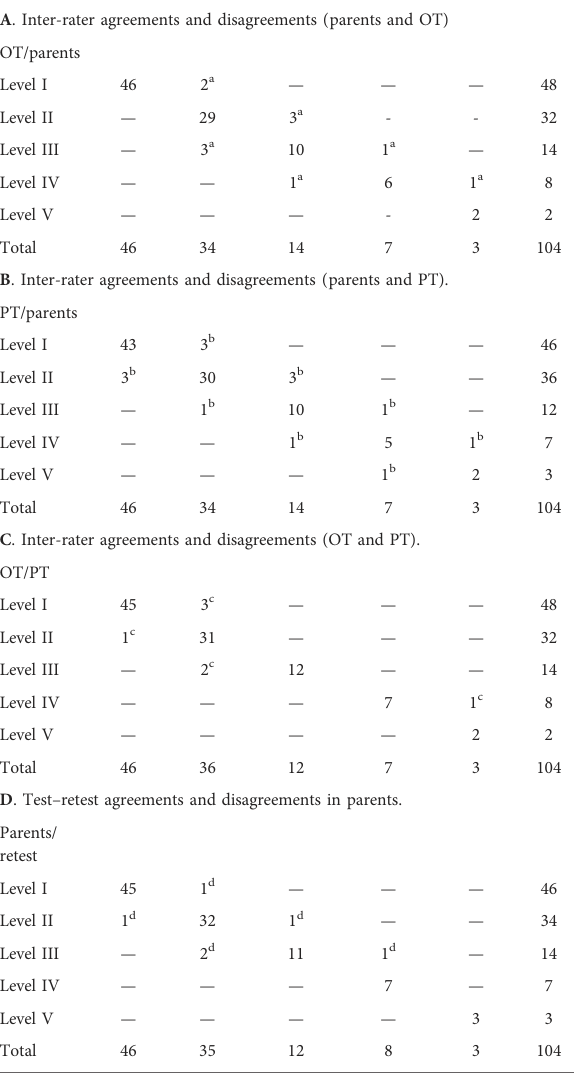
TABLE 2 Numbers of the Mini-Manual Ability Classi fi cation System levels between different